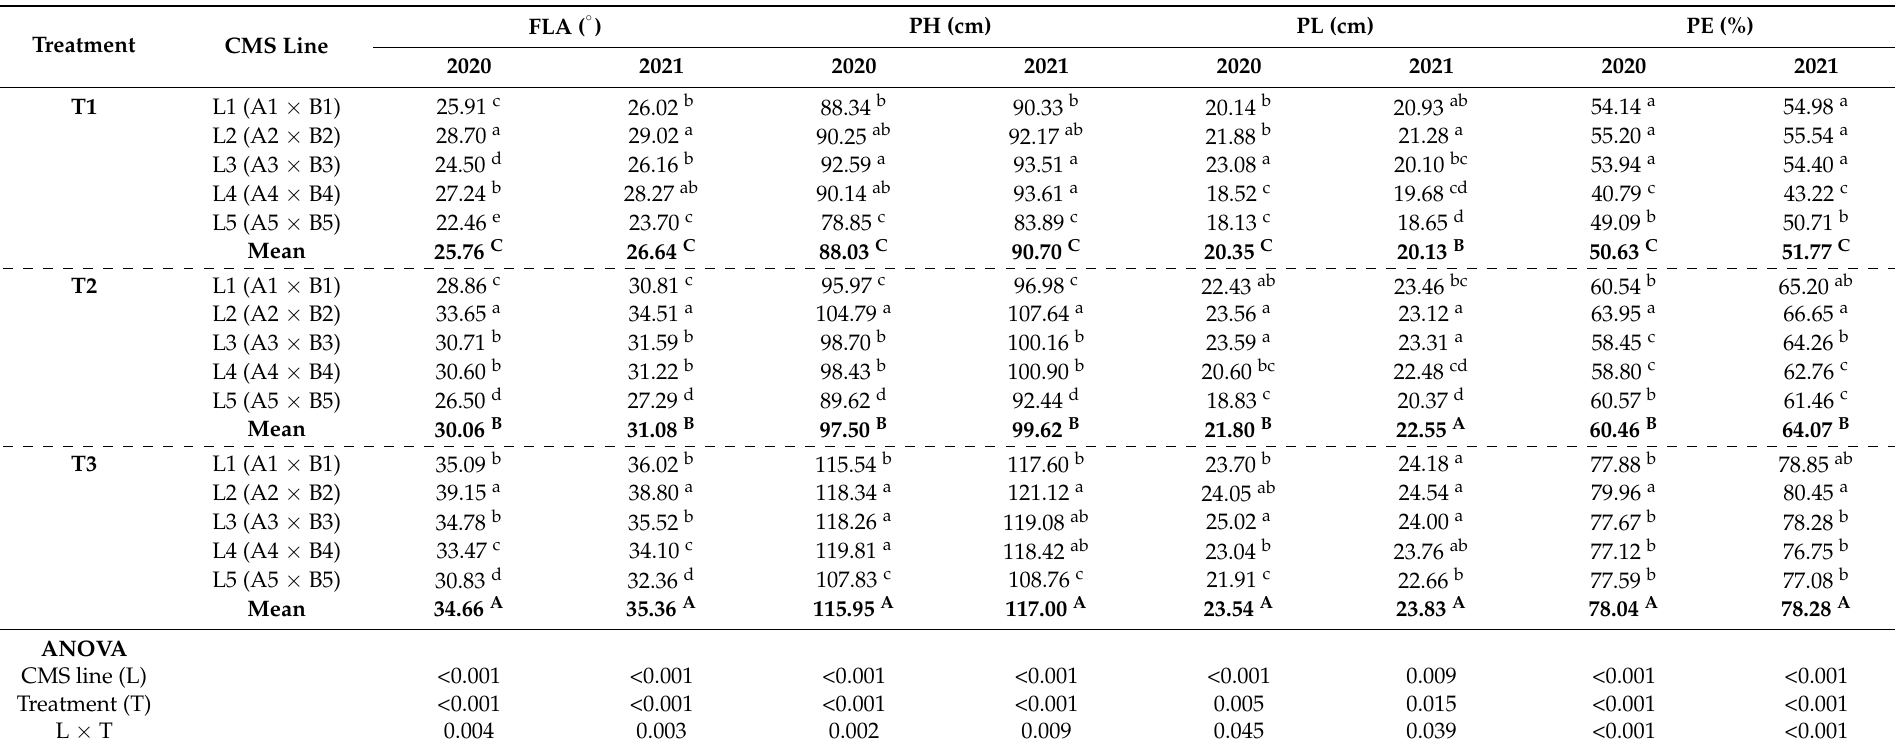
Table 2. Influence of growth regulators on flag leaf angle (FLA), plant height (PH), panicle length (PL), and panicle exertion (PE) of five diverse CMS lines.